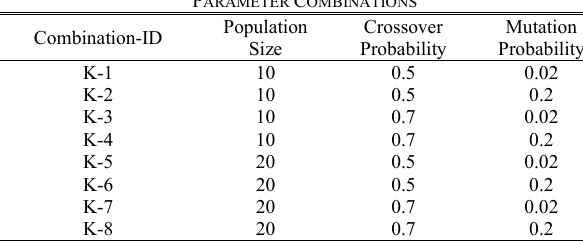
TABLE 1 P ARAMETER C OMBINATIONS